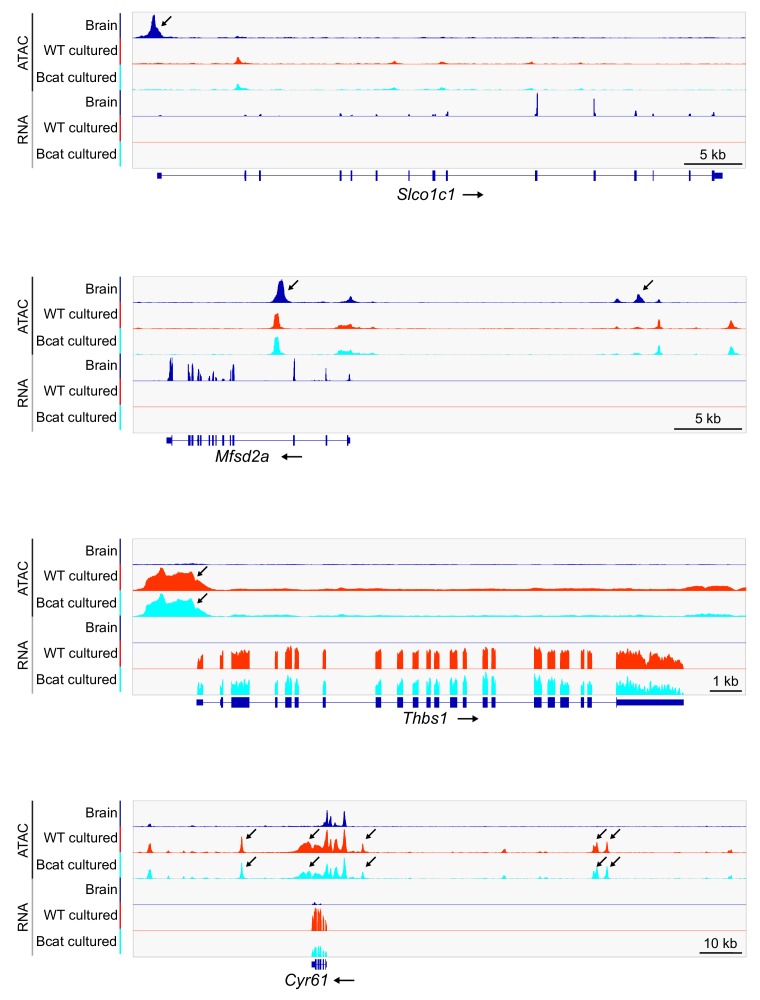
WT and beta-catenin stabilized brain ECs in culture have nearly identical patterns of transcription and accessible chromatin.Genome browser images showing ATAC-seq reads (top) and RNA-seq reads (bottom) for the same set of genes shown in Figure 2A for freshly isolated adult brain ECs, WT cultured adult brain ECs, and beta-catenin stabilized and cultured adult brain ECs. Read counts are averaged over the independent replicates. Arrows indicate ATAC-seq peaks that correlate with differential gene expression.